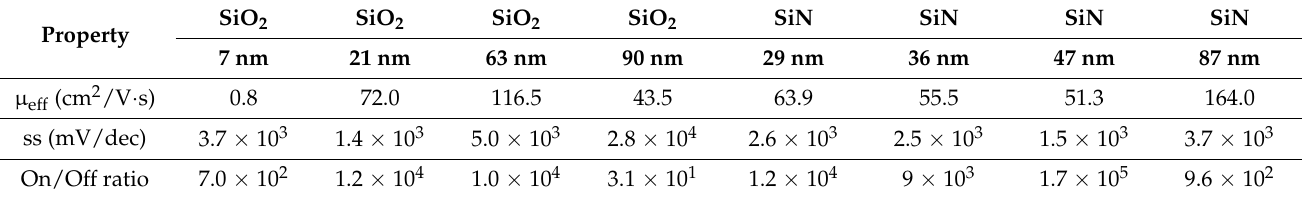
Table 1. Electrical mobilities, subthreshold swing (ss) values, and on/off ratios of